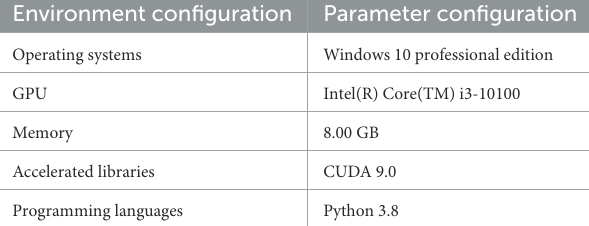
TABLE 5 Experimental environment